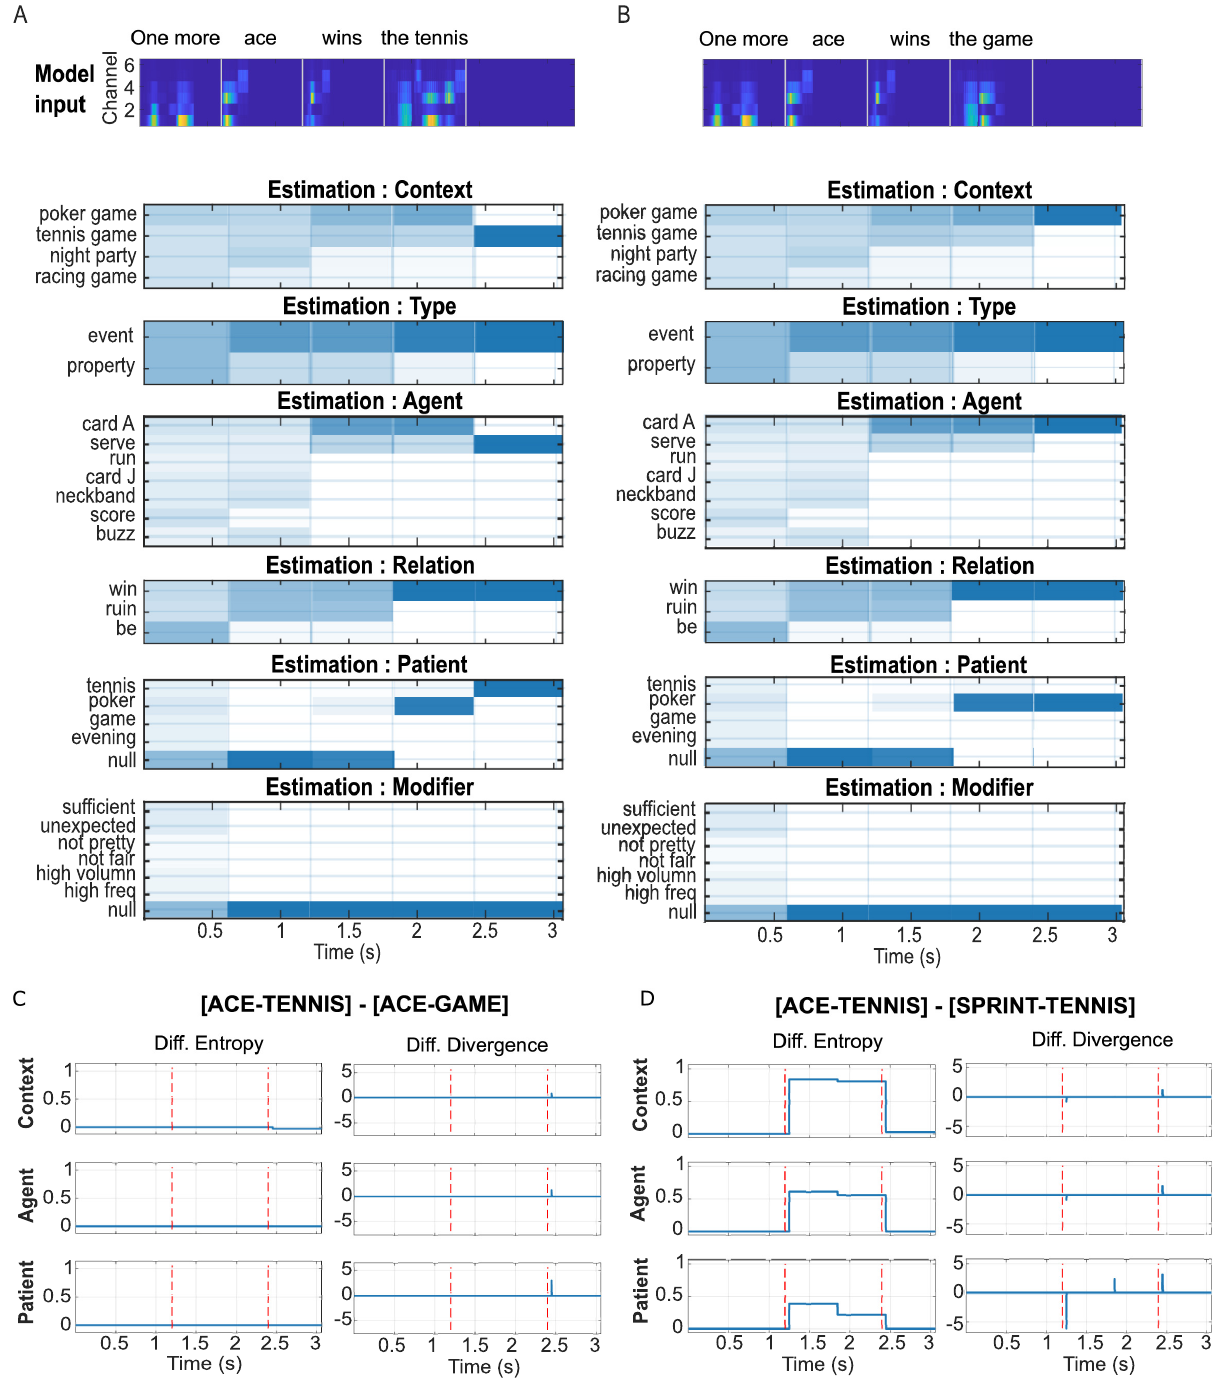
Fig 2. Semantic- and context-level model response to different sentence inputs. For all simulations, relative prior for context was set at the default of 1.5:1:1:1 for the four possibilities {‘poker game’, ‘tennis game’, ‘night party’, ‘racing game’}. ( A ) Top panel: acoustic spectrogram of input sentence A: “One more ace wins the tennis”. Vertical grey lines mark the offset of each lemma, at which point updates were sent from the lemma level to semantic and context. Lower panels: estimation of posterior probabilities for the semantic ( agent , patient , relation , modifier ) and context states as the sentence unfolds. Possible values of each factor are labelled on the y-axis. Blue scale blocks indicate the probability distribution for each factor, dark blue— p = 1, white— p = 0. The updating process is nearly instantaneous, and the main body of the n th block (epoch corresponding to one lemma) is filled with the estimates after the (n-1) th update. The first input “one more” was not informative. The estimated distributions were slightly changed before and after the offset of “one more” because the model still performed gradient descent to minimize free energy (see Methods). After hearing “ace”,